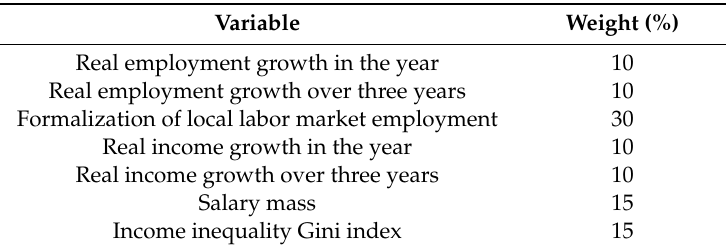
Table 1. Employment and Income Area - Weights of Variables.